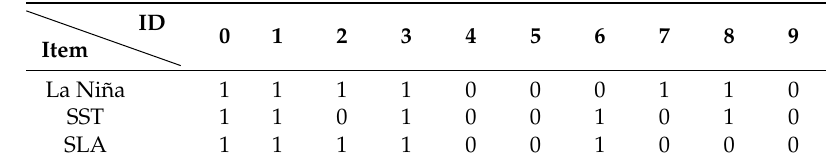
Table 1. Boolean datasetfor Example